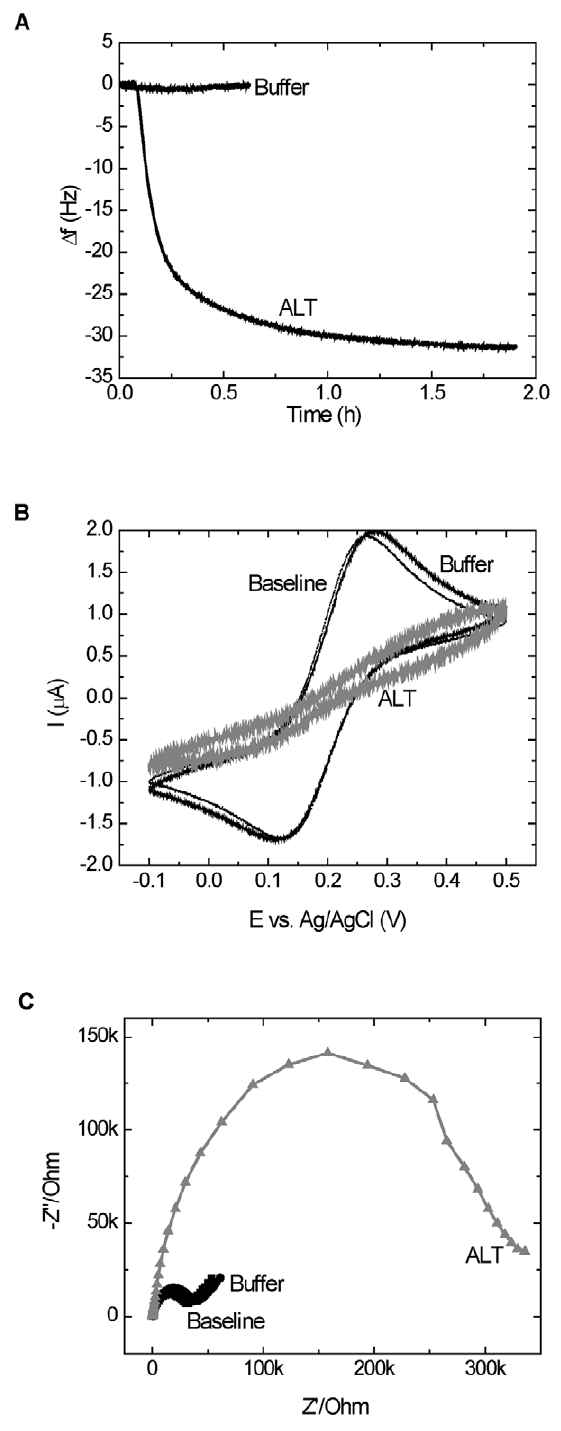
Figure 6. Sensor operation. A) QCM frequency change of Au-Pep- Cys electrode in Buffer alone and in 10 m g/mL ALT, B) CV of Au-Pep-Cys electrode before (Baseline) and after Buffer alone or ALT binding, C) EIS of Au-Pep-Cys before (Baseline) and after Buffer alone or ALT binding. After incubation in Buffer or 10 m g/mL ALT, the electrodes were transferred to 1 mM solution of Fe(CN) 64-/3- in 0.1 M NaClO 4 for the EIS measurements.